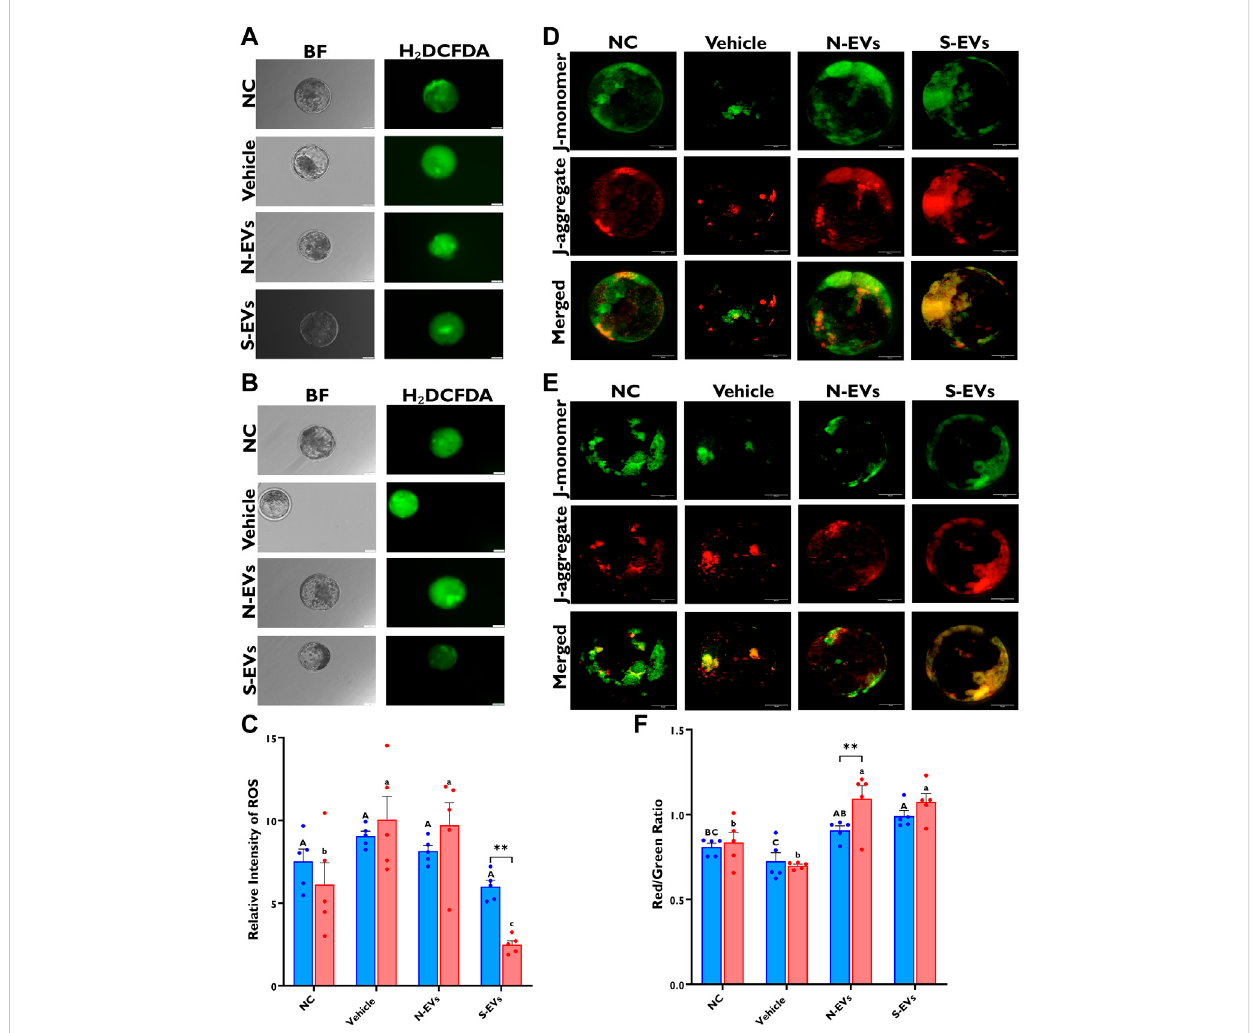
and HS (41 ° C; red) conditions. Fluorescence images of in vitro cultured bovine blastocysts treated with 2 ʹ ,7 ʹ -Dichloro fl uorescin Diacetate (H ₂ DCFDA) werecapturedforthemeasurement ofintracellularROSlevels insingle blastocysts.Scalebar,50 µM[38.5 ° C; (A) ][41 ° C; (B) ].Quanti fi cationoftherelative fl uorescenceintensityinsingleblastocystswerecarriedoutintriplicates(atotalof6-9blastocystspertreatment) (C) .Fluorescenceimagesof invitro culturedbovineblastocyststreatedwith5,5 ′ ,6,6 ′ -tetrachloro-1,1 ′ ,3,3 ′ tetraethylbenzimidazolylcarbocynanineiodide(JC-1)forthemeasurementofMMP ( Δ Ψ m), an indicator of mitochondrial activity in single blastocysts. Scale bar, 50 µM [38.5 ° C; (D) ] [41 ° C; (E) ]. Quanti fi cation of the relative fl uorescence intensity (red/green ratio) in single blastocysts were carried out in duplicates (a total of 7 – 11 blastocysts per treatment) (F) . Data among treatments represent the mean ± SEM and the differences between means were analyzed using Two-way ANOVA followed by Tukey ’ s Multiple Comparisons Test. Barswithdifferentletters(38.5 ° C;uppercase)(41 ° C;lowercase)indicatestatisticallysigni fi cantdifferencesofatleast( p < 0.05)betweentreatmentsunder the same culture conditions, while (*) indicate statistical differences between the same treatment under different culture environments during IVM (** p <